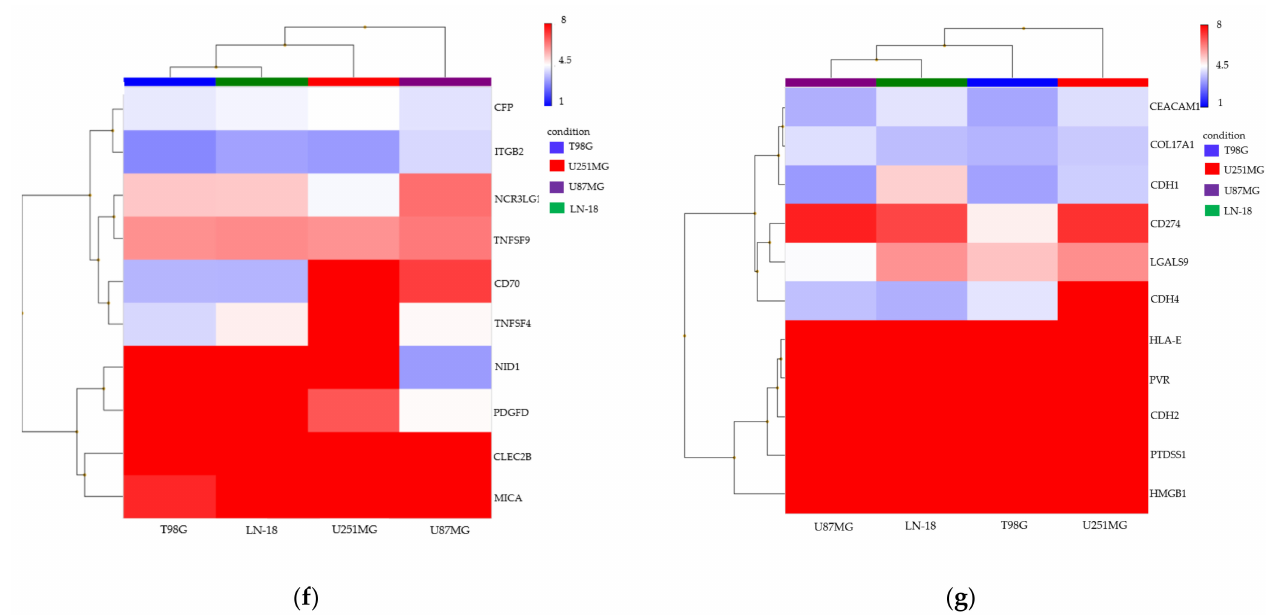
Figure 3. Hierarchical clustering of gene expression in spheroids derived from LN-18, T98G, U87MG, and U251MG GBM cell lines. ( a ) Morphology of each GBM cell line (LN-18, T98G, U87MG, and U251MG) in spheroid culture conditions; scale bar = 500 µ m. ( b – g ) The heatmaps of the transcriptome-wide Clariom™ S array of gene expression related to GSC markers ( b ), ECM markers ( c ), chemokines ( d ), chemokine receptors ( e ), NK cell activation receptor ligands ( f ), and NK cell inhibitory receptor ligands ( g